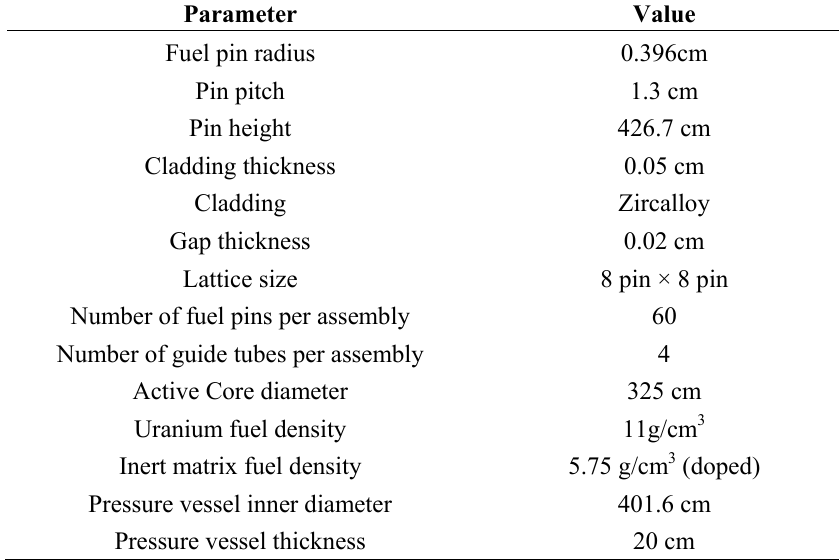
Table 1. Fuel assembly parameters.